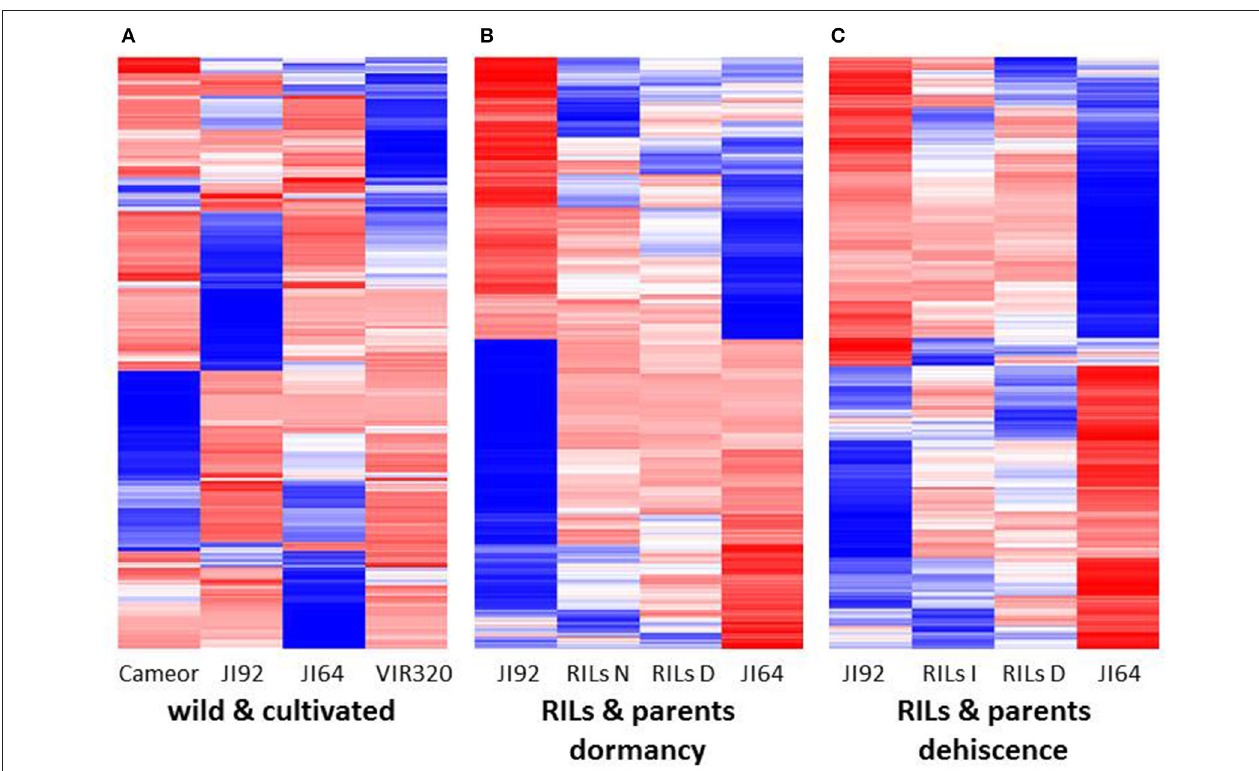
FIGURE 8 | The heat maps (A) of 1,000 genes with the highest variance among normalized expression values for cultivated and wild pea samples, (B) of 11,808 DEGs for dormancy, and (C) of 6,259 DEGs for dehiscence between RIL’s parents samples in MACE experiments.